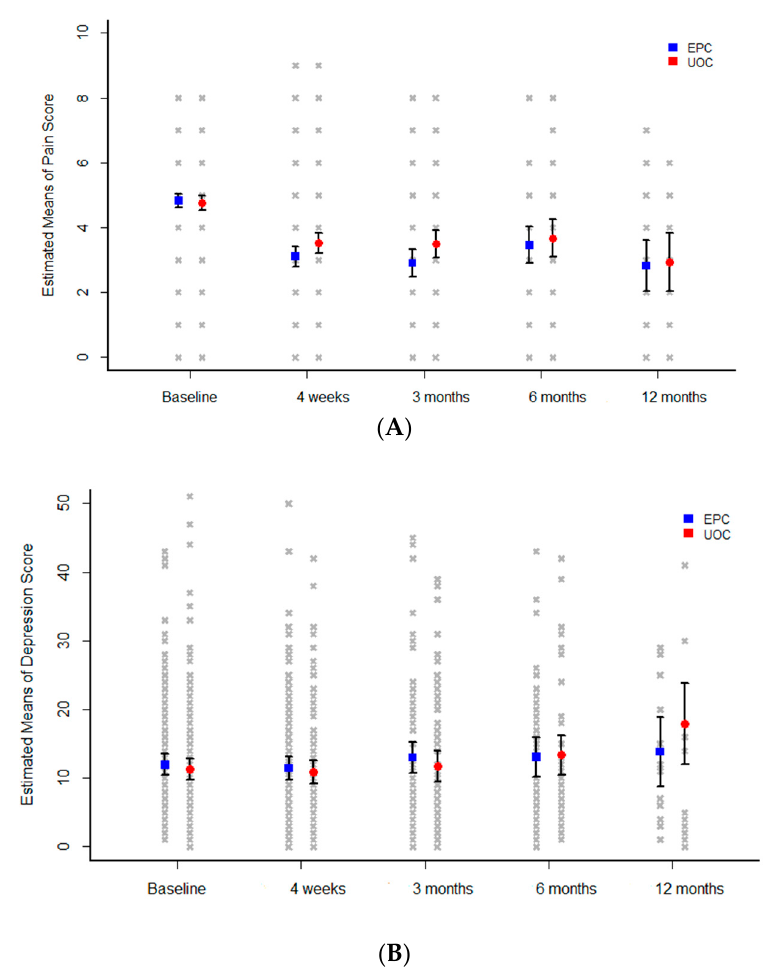
Figure 2. Mean changes in ( A ) pain scores and ( B ) depression scores among patients in the EPC (blue) and UOC (red) groups. EPC: Early palliative care, UOC: Usual oncology care. Patients in both study groups reported improvements in assessment of pain intensity by week 4. Mean decrease in score was significantly greater in the EPC than in the usual care group (1.5-point vs. 1.0-points, p = 0.0318, Figure 3, Supplementary Table S2).